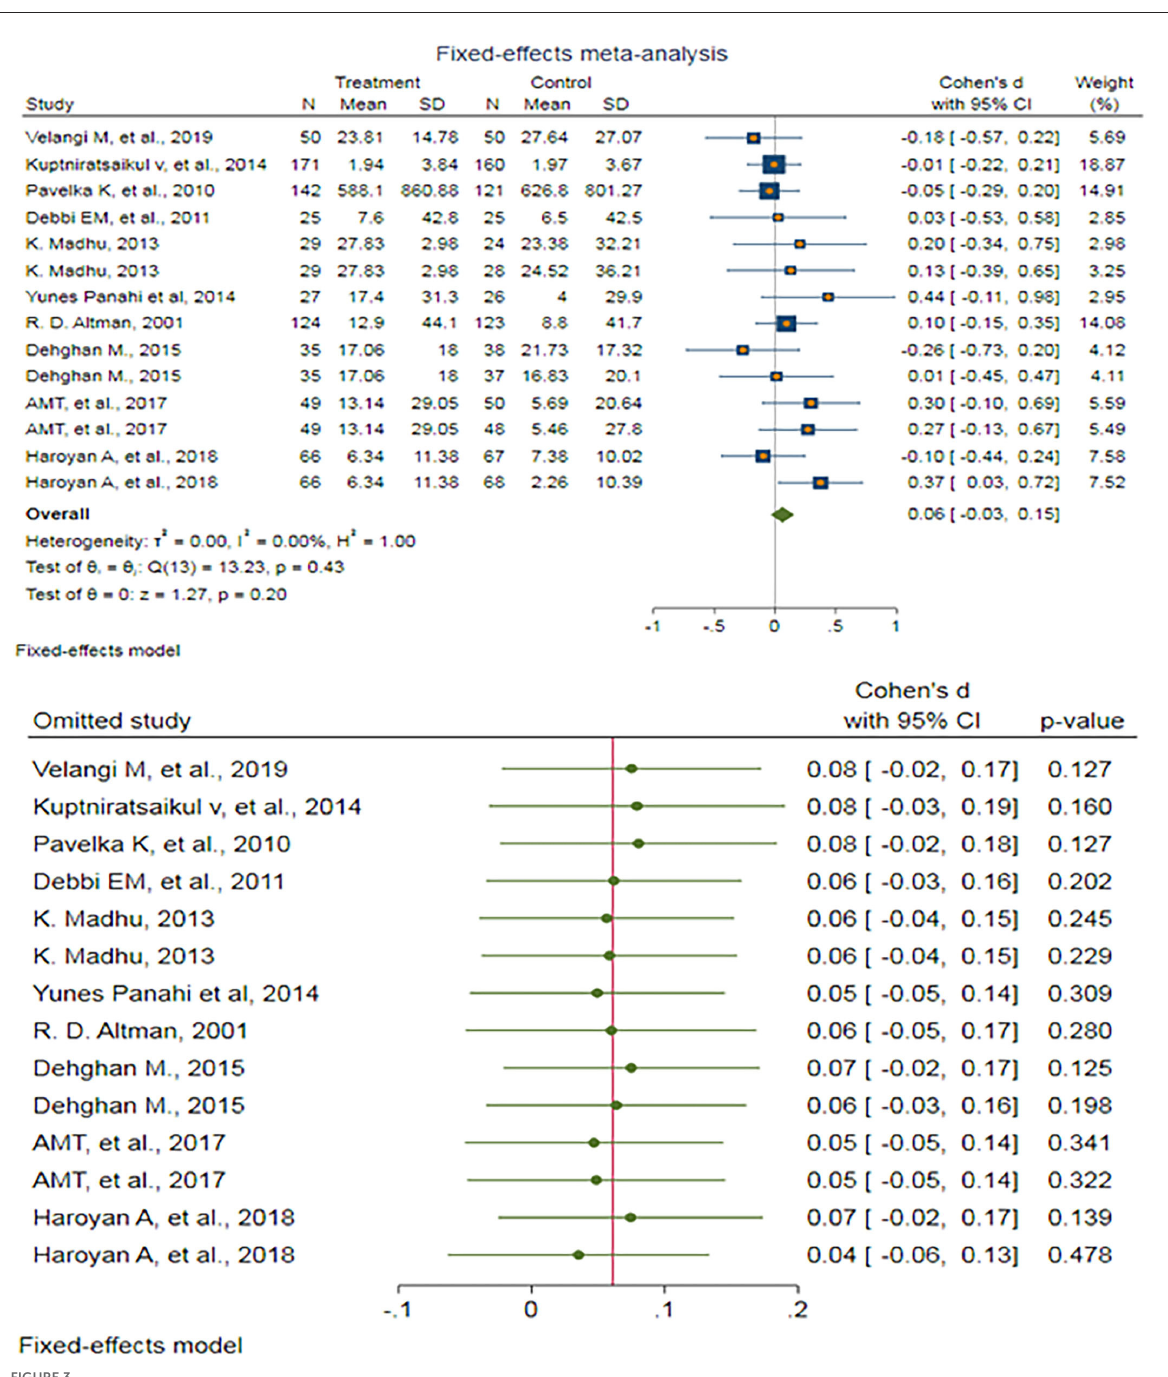
The Galbraith plot (Supplementary Figure S22) revealed intercept: 0.64 (95%CI: 2.58–3.87), p 0.685). Begg’s funnel − = plot of SE vs. effect size (SMD) was symmetrical to some extent that seven studies were outside the 95%CI, which means that (Supplementary Figure S21). they are